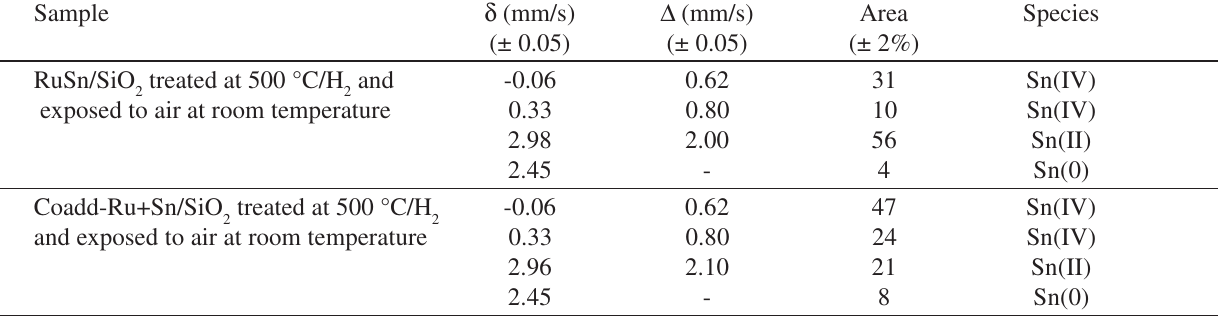
supported RuSn catalysts submitted to different treatments. 2